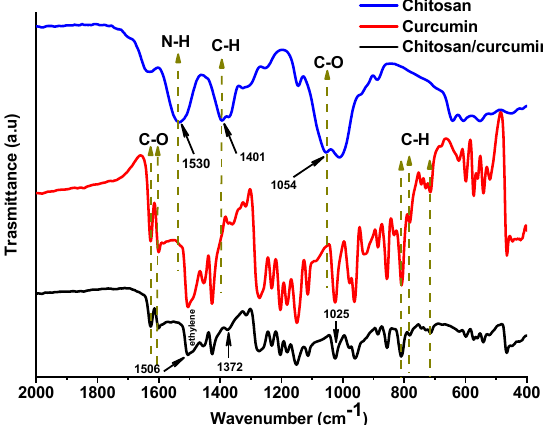
Figure 6. FTIR spectra of curcumin and chitosan coatings on 316L SS and chitosan/curcumin composite coatings on 316L SS. The relevant peaks are discussed in the text.